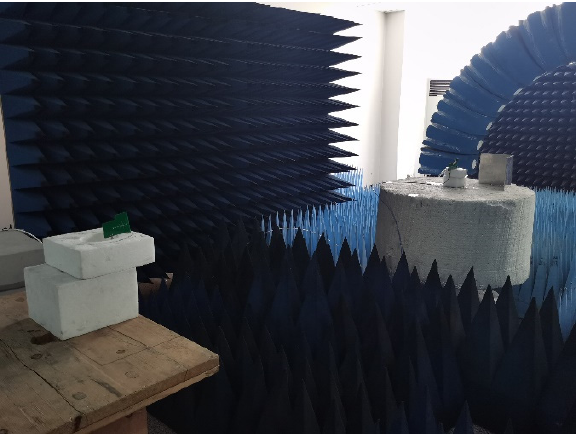
Figure 12. Experiment Ⅲ test scene.